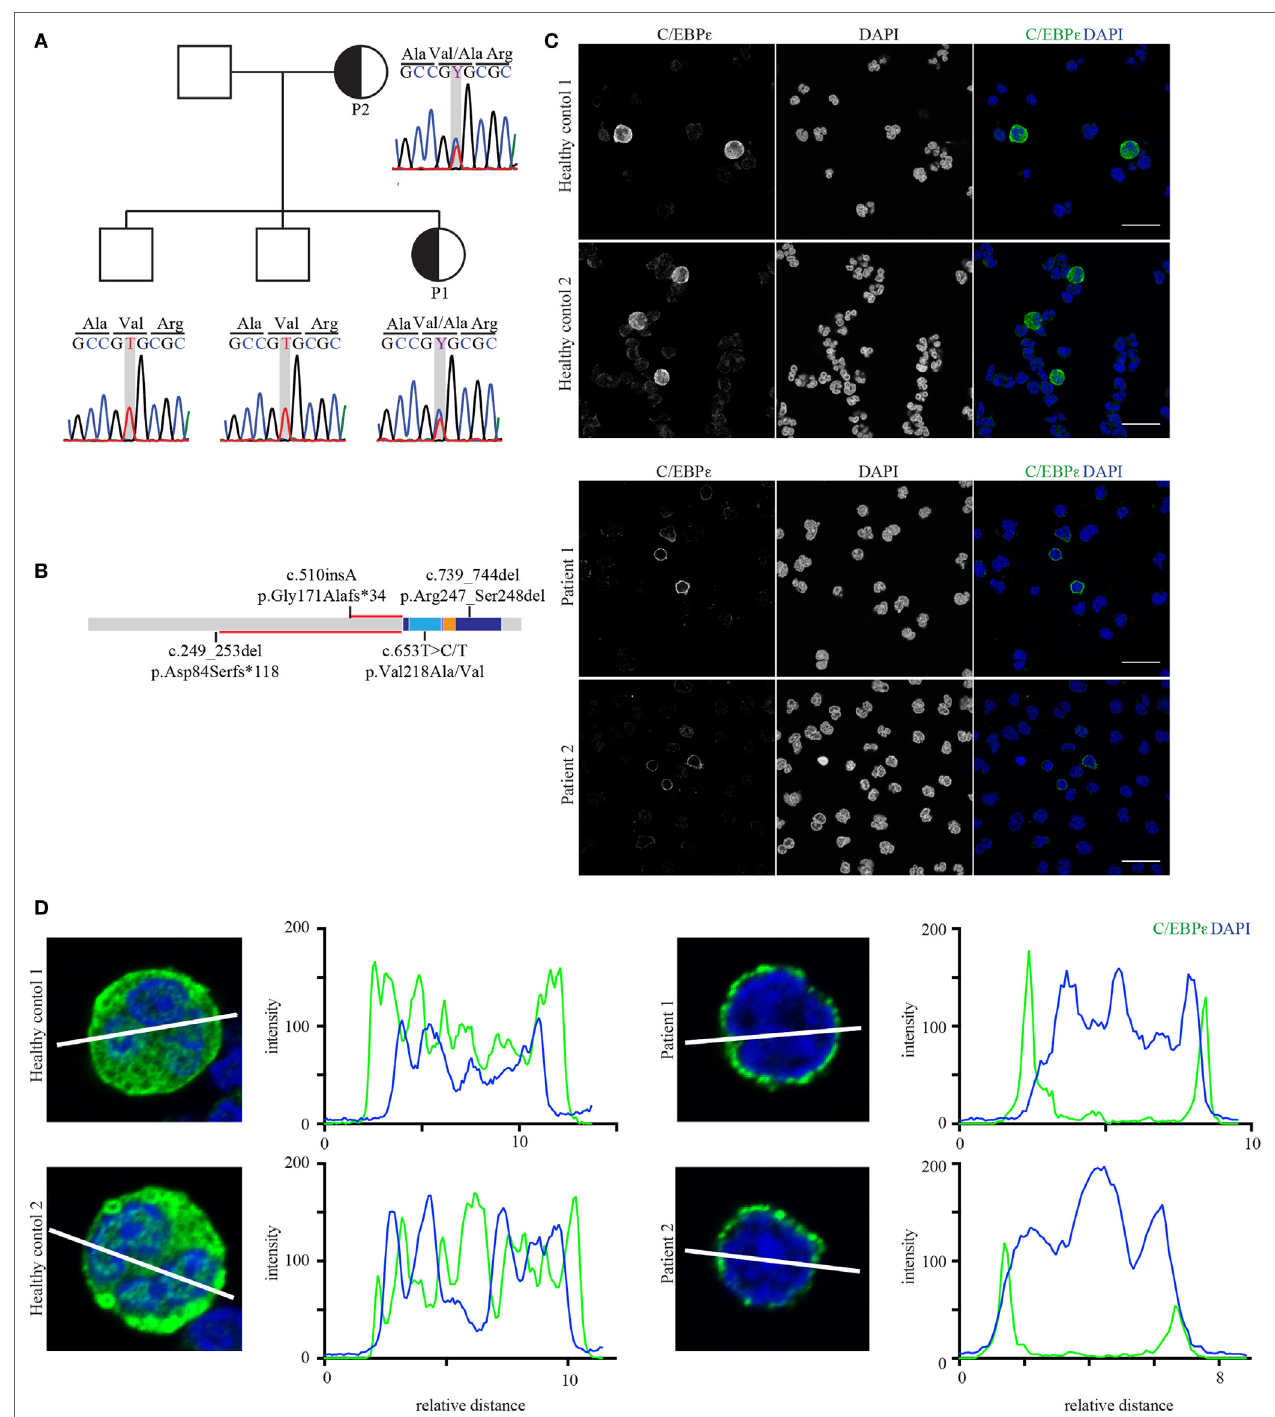
FigUre 2 | The affected mother and child both carry the heterozygous mutation p.Val218Ala in CEBPE . (a) Sanger chromatograms of the core pedigree covering the mutated nucleotide (framed gray) in CEBPE . (B) Protein model including domain structure of C/EBP ε (basic leucine zipper: dark blue; basic subunit: light blue; and leucine zipper: orange) showing the relative location of the identified mutation in relation to the homozygous frameshift mutations. The length of the altered reading frames is indicated in red. (c) Confocal images of healthy control and patient granulocytes stained for C/EBP ε (green, scale bar: 20 µm). Stains were performed in triplicates. (D) Line graphs of C/EBP ε and DAPI show that in patients’ cells the center of the nucleus lacks C/EBP ε which rather localizes to the perinuclear region (blots were done with